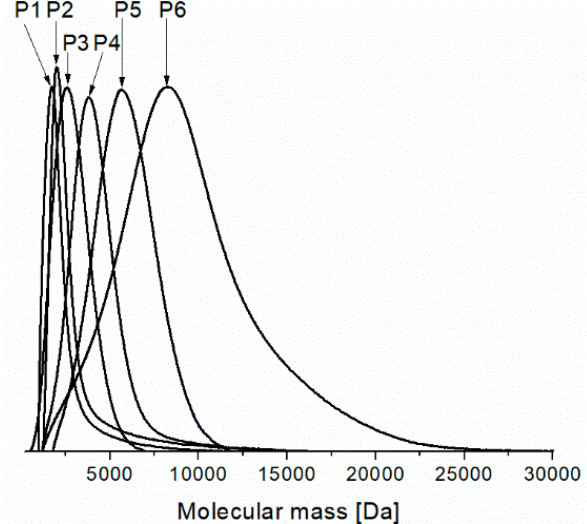
Figure 2. The molecular weight distribution curves from Size-Exclusion Chromatography (SEC) analyses for the prepared PNIPAMs (descriptions of the samples P1–P6 and polymerization conditions are given in Table 1).